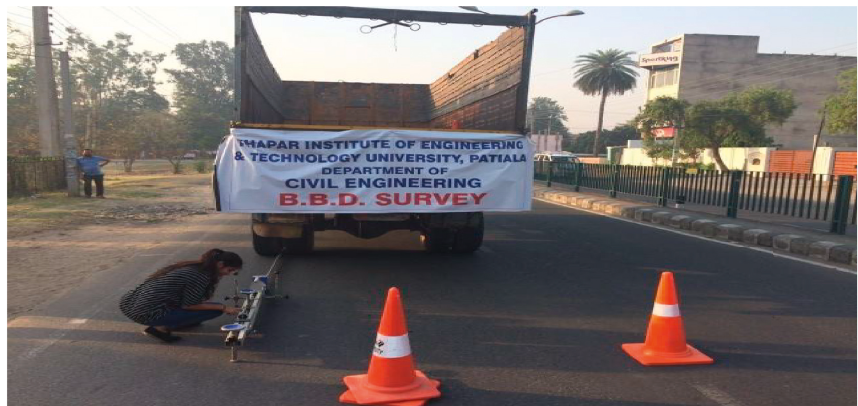
Figure 2: BBD test in progress at chainage 0.350km on the section UR02.